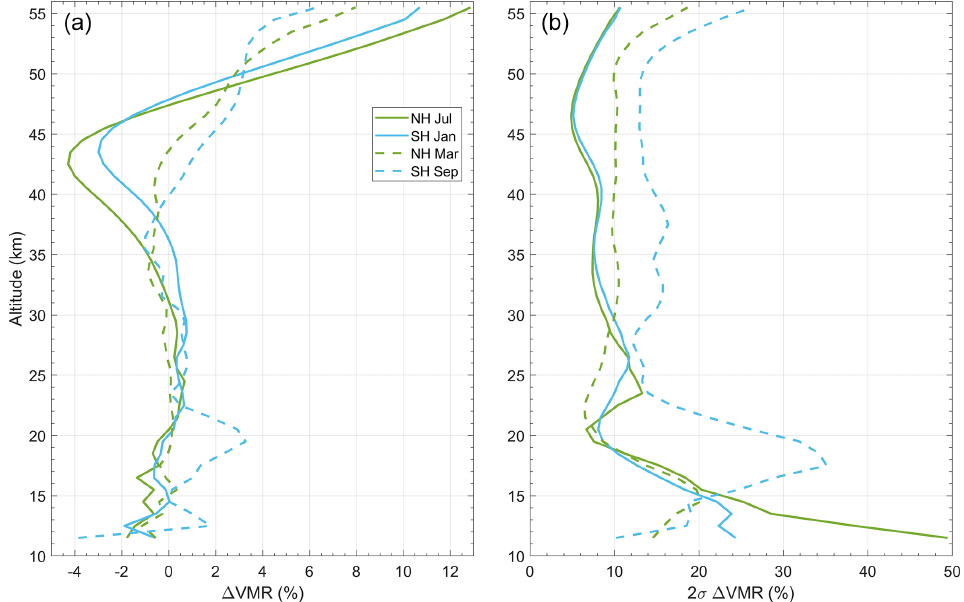
Figure 8. Ensemble mean bias (a) and 2 σ geophysical variability (b) between ACE-FTS and OSIRIS O 3 in the polar regions at coincidence criteria of within 8h and 1000km, as estimated from CMAM, EMAC, and WACCM